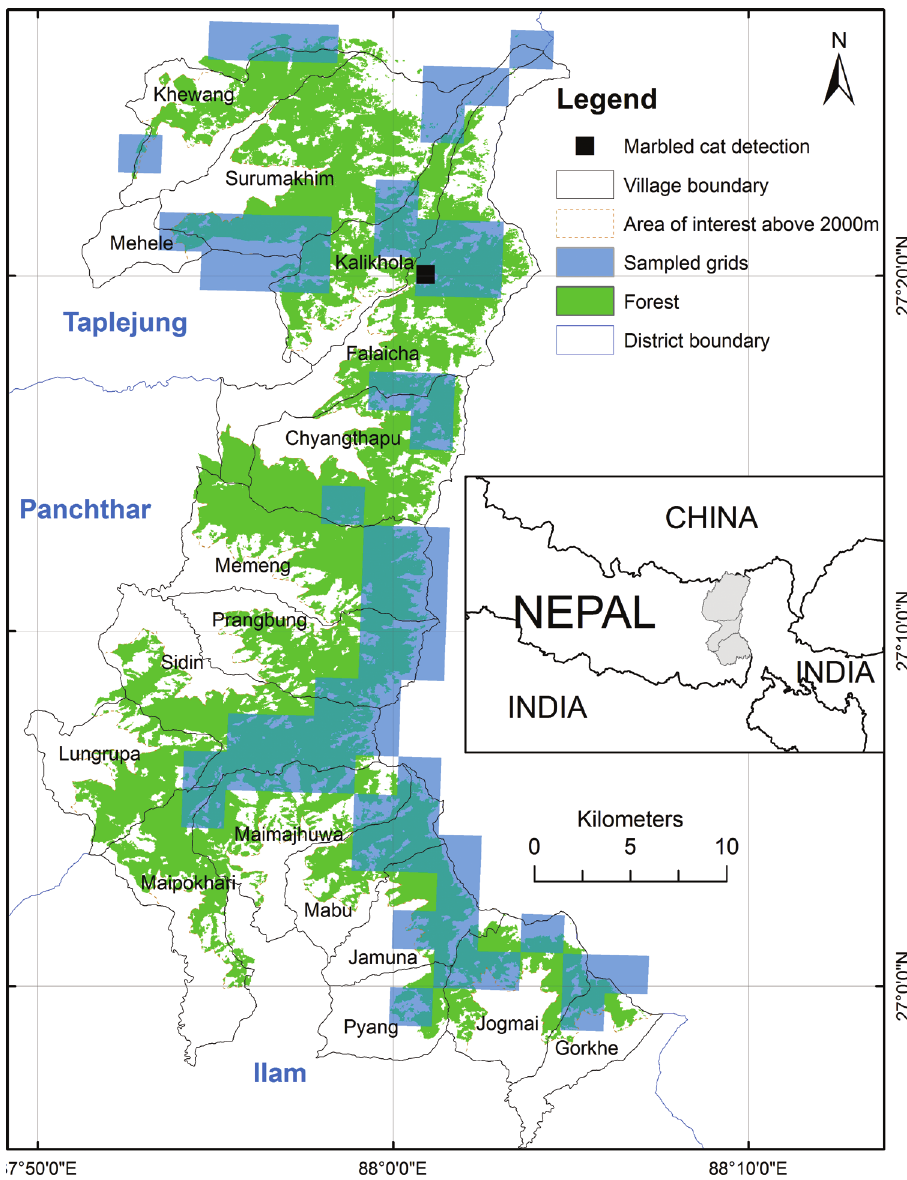
Figure 1. A map of the study area in Southern Kangchenjunga Landscape in eastern Nepal showing sampled grids in blue and location of the marbled cat